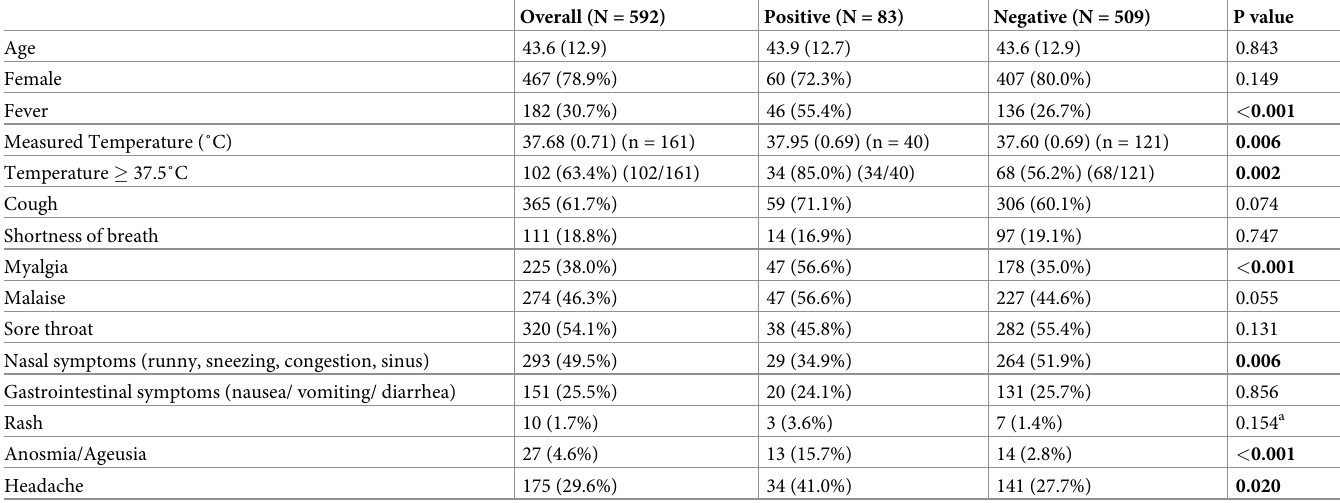
Table 1. Symptom and body temperature distributions at time of triage among healthcare workers (HCWs) by SARS-CoV-2 test results.